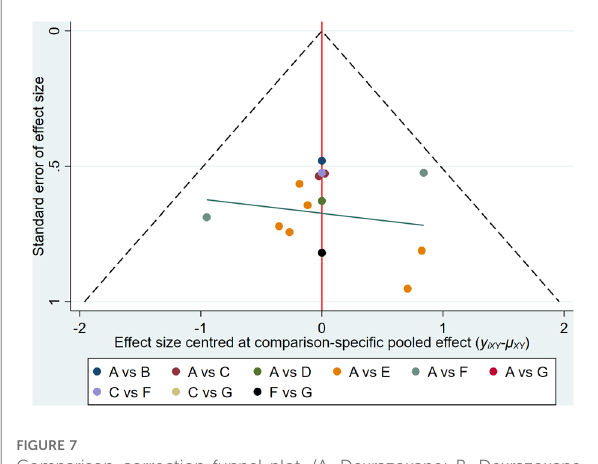
FIGURE 7 Comparison-correction funnel plot. (A, Dexrazoxane; B, Dexrazoxane combined with Wenxinkeli; C, Dexrazoxane combined with Cinobufotalin injection;